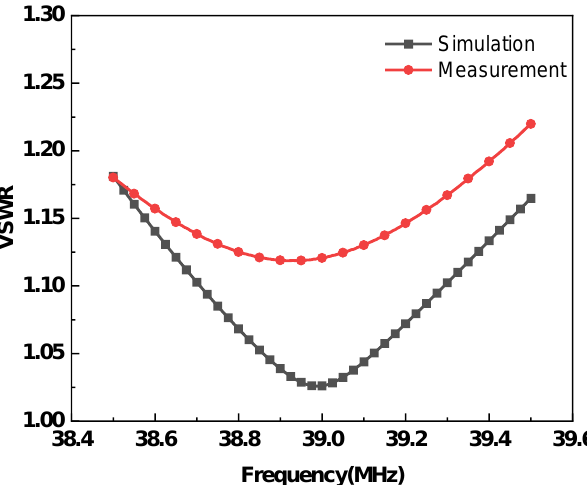
Figure 7. The fabricated antenna unit ( a ) and array ( b ).